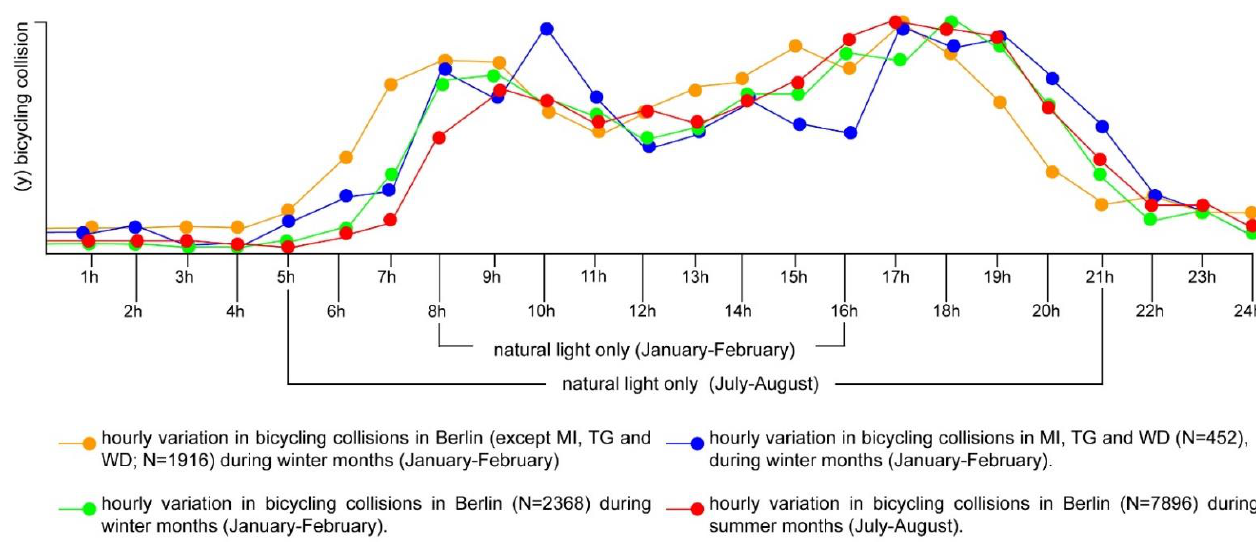
Figure 9. Hourly distribution of bicycling crashes with motorized vehicles in Berlin during Sommer and Winter months. Data source: Berlin Police. Figure source: the authors.